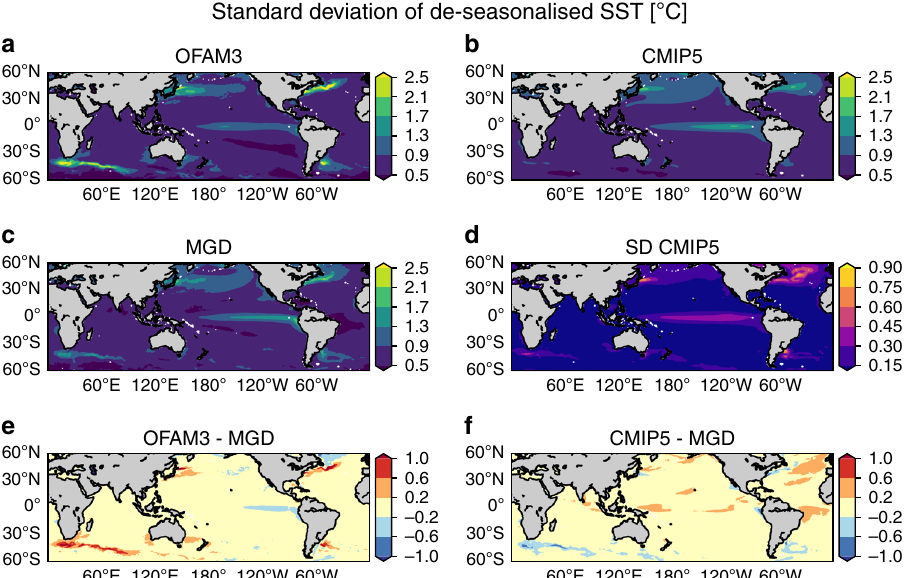
Fig. 3 Historical standard deviation of de-seasonalised daily sea surface temperature. Spatial distributions of standard deviation of de-seasonalised daily sea surface temperature (SST) averaged over 1982 – 2018 based on a a high-resolution ocean model (OFAM3), b the multi-model mean product of 23 global climate models (CMIP5) and c observations (MGD). d Inter-model spread of the CMIP5 models, as determined by standard deviations. Biases in e OFAM3 and f the CMIP5 multi-model mean product, as determined by their difference from MGD.